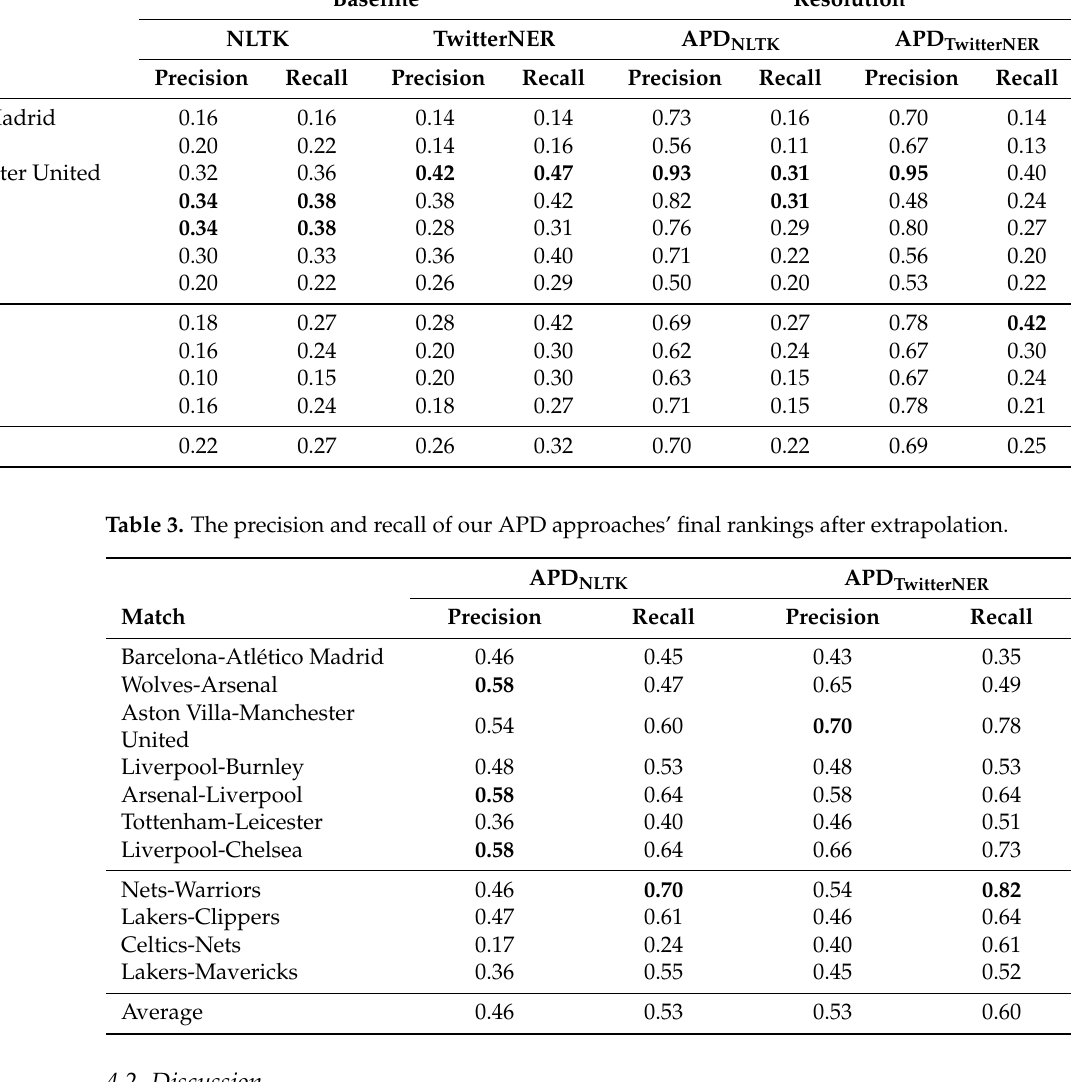
Table 2. The precision and recall of the rankings produced by the baselines and by our APD approaches after resolution. Baseline Resolution NLTK TwitterNER APD NLTK APD TwitterNER Match Precision Recall Precision Recall Precision Recall Precision Recall